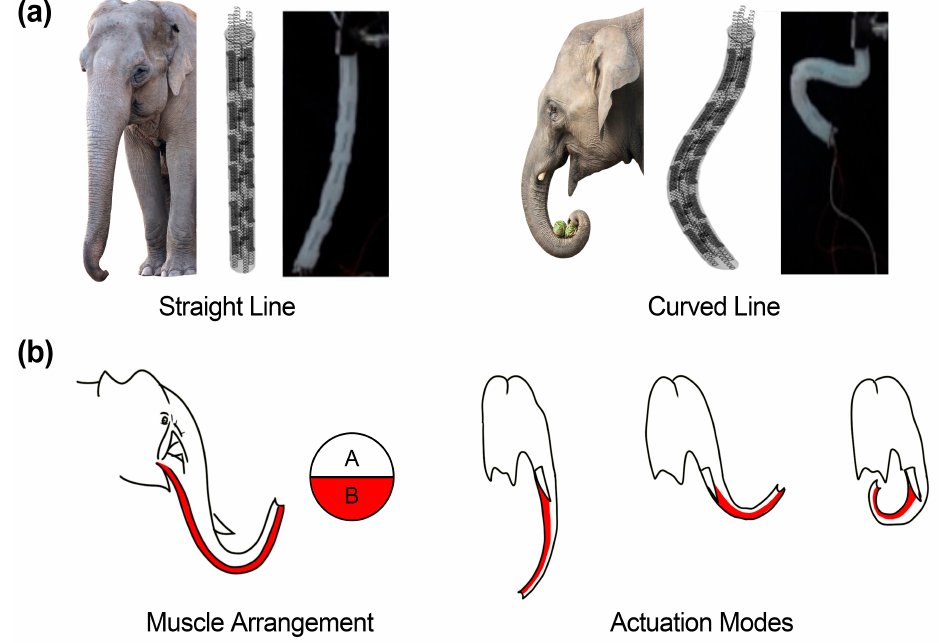
Figure 1. ( a ) Images of the elephant trunk, the 3D model of the elephant trunk actuator; and the actual actuator; ( b ) Muscles of an elephant’s trunk; elephant trunks are composed of two long muscles, which can produce various movements, redrawn from [29].